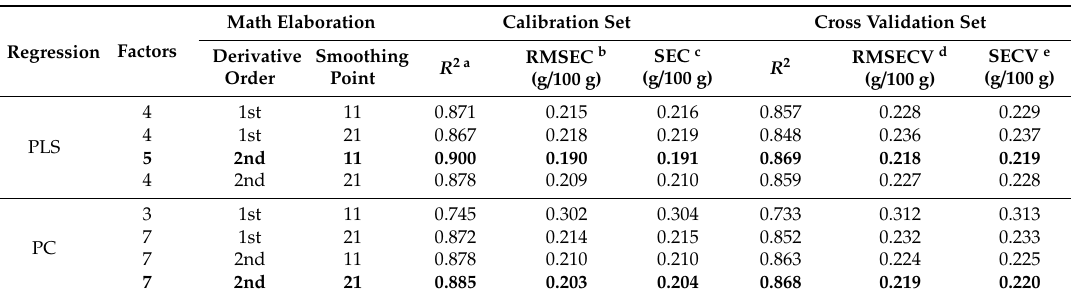
Table 2. Optimum calibration parameters according to partial least squares (PLS) and principal components (PC) regression